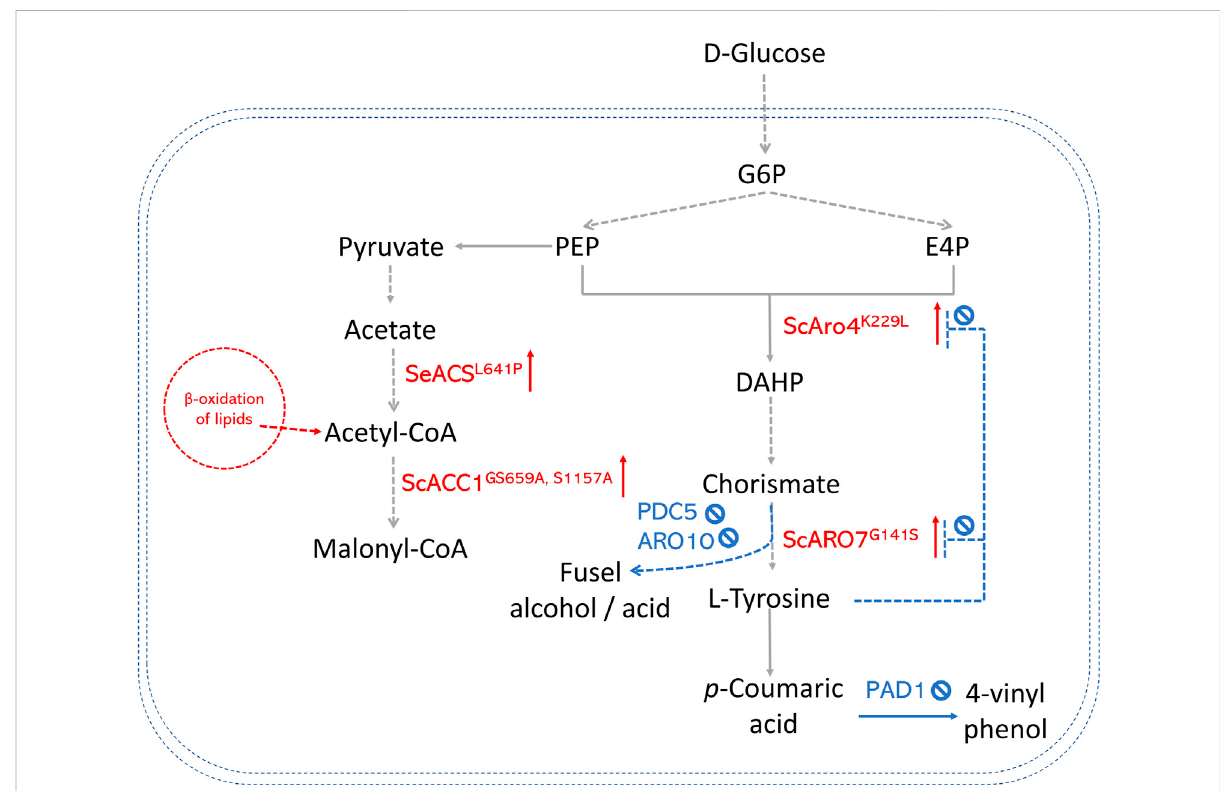
FIGURE 3 An overview of precursor enhancement engineering in S. cerevisiae . Genes and enzymes in red are overexpressed. Genes and enzymes in blue are deleted. Dotted arrows refer to multiple steps. G6P, glucose-6-phosphate; PEP, phosphoenolpyruvate; E4P, erythrose-4-phosphate; DAHP, 3- deoxy-D-arabino-2-heptulosonic acid 7-phosphate; ARO4K229L, DAHP synthase feedback inhibition resistant variants; ARO7G141S, chorismate mutase feedback inhibition resistant variants; PAD1, phenyl acrylic acid decarboxylase; PDC5, pyruvate decarboxylase; ARO10, phenylpyruvate decarboxylase; ACS, acetyl-CoA synthase; ACC, acetyl-CoA